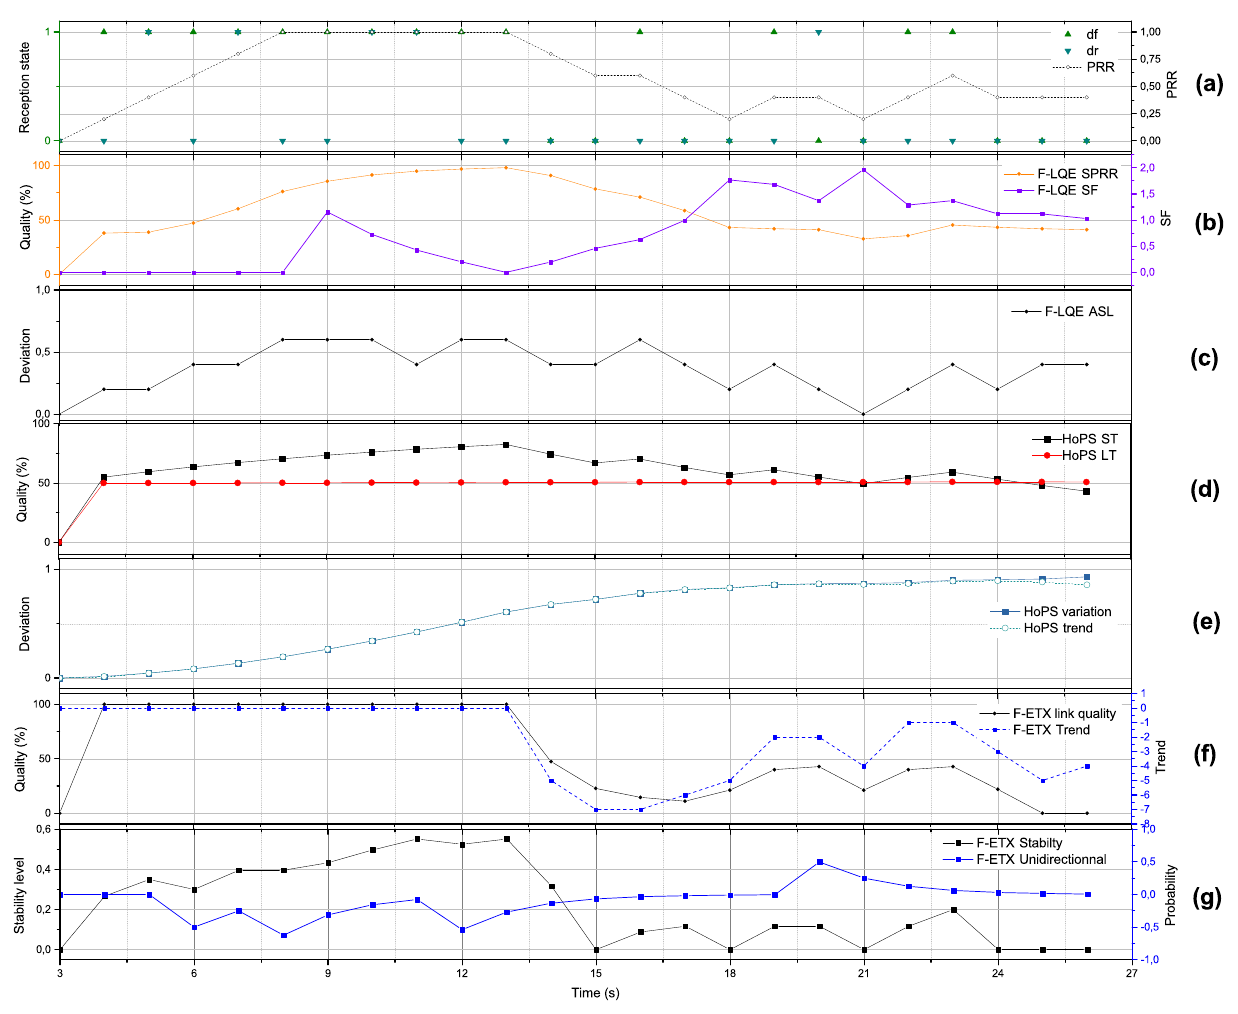
Figure 10. Lowspeed